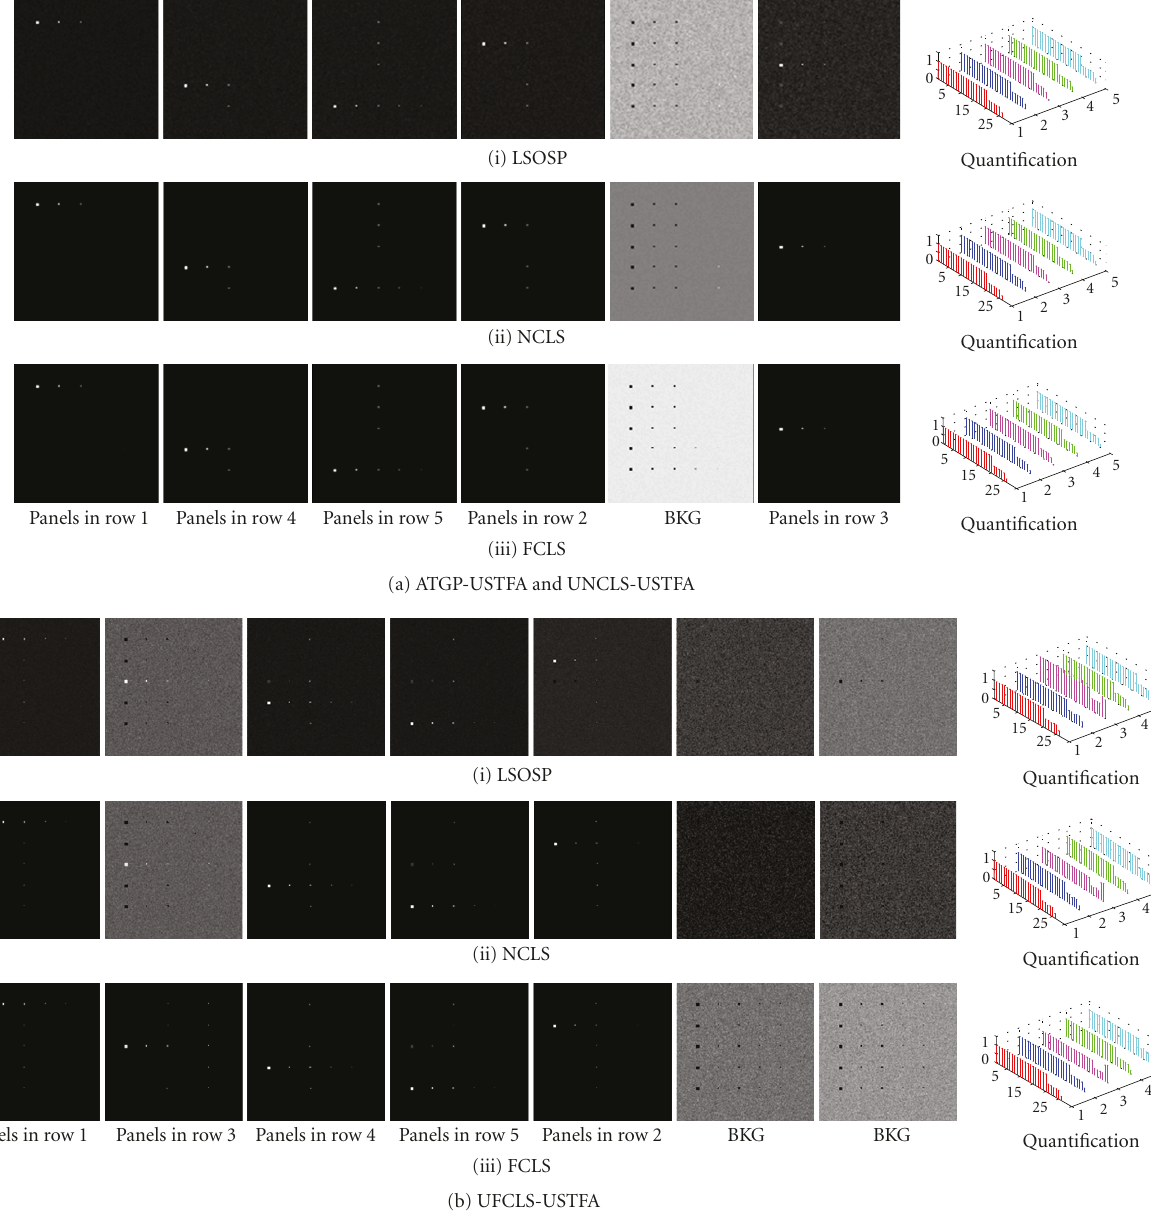
Figure 12: Results of using LSOSP, NCLS, and FCLS to unmix TE via the target pixels found in Figure